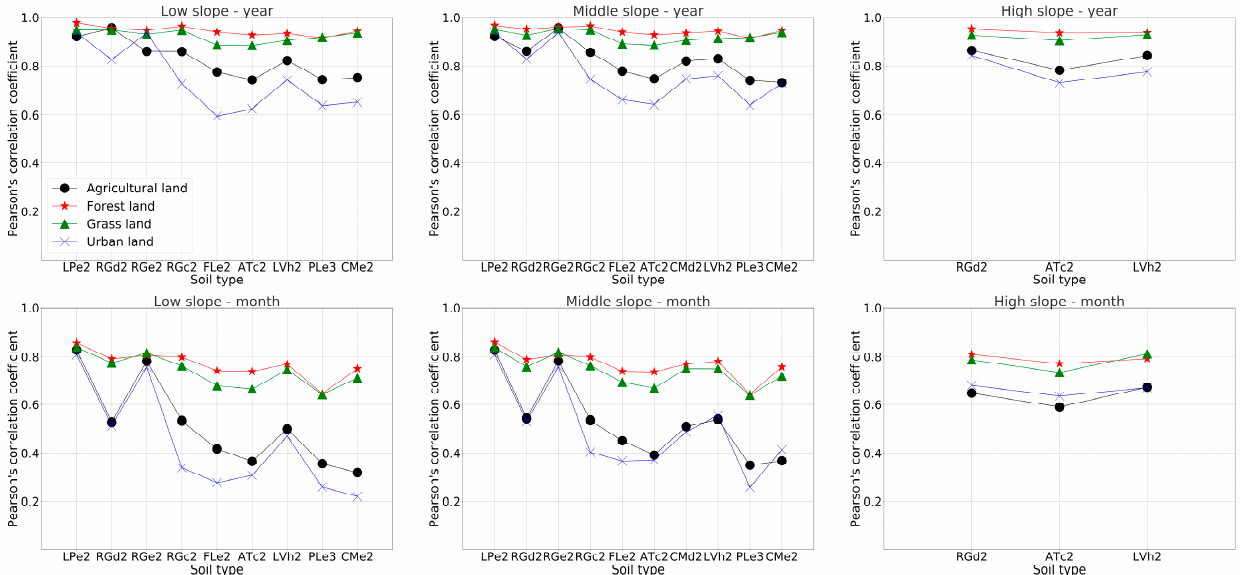
Figure 5. The PCC of the precipitation and baseflow for different combinations of land use, soil type, and slope. The low slope, middle slope, and high slope represented the slope ranges 0–10, 10–25, and 25–40, respectively. “Year” and “month” mean the data of the samples were on a yearly and monthly scale, respectively. The soil type name of each soil type code is defined in Figure 3.